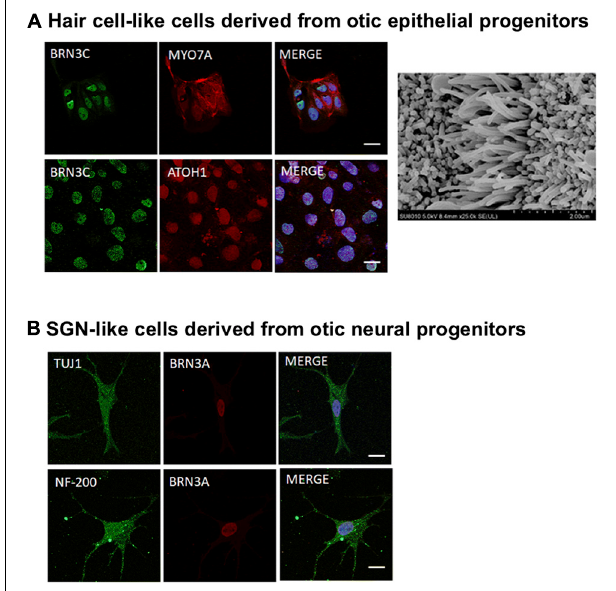
FIGURE 5 | Differentiation of otic progenitor cells in vitro . (A) (Left) hair cell-like cells derived from otic epithelial progenitors (OEPs) expressed hair cell markers BRN3C (green), MYO7A (red), and ATOH1 (red) (scale bars = 20 µ m). (Right) SEM showing apical projections outside hair cell-like cells which are reminiscent of stereocilia (scale bar = 1 µ m). (B) SGN-like cells derived from otic neural progenitors (ONPs) expressed markers NF200 (green), TUJ1 (green), and BRN3A (red) and formed dendrite-like protrusions (scale bars = 20 µ m). (A,B) Adapted from Chen et al. (2018), available under Creative Commons license (CC BY